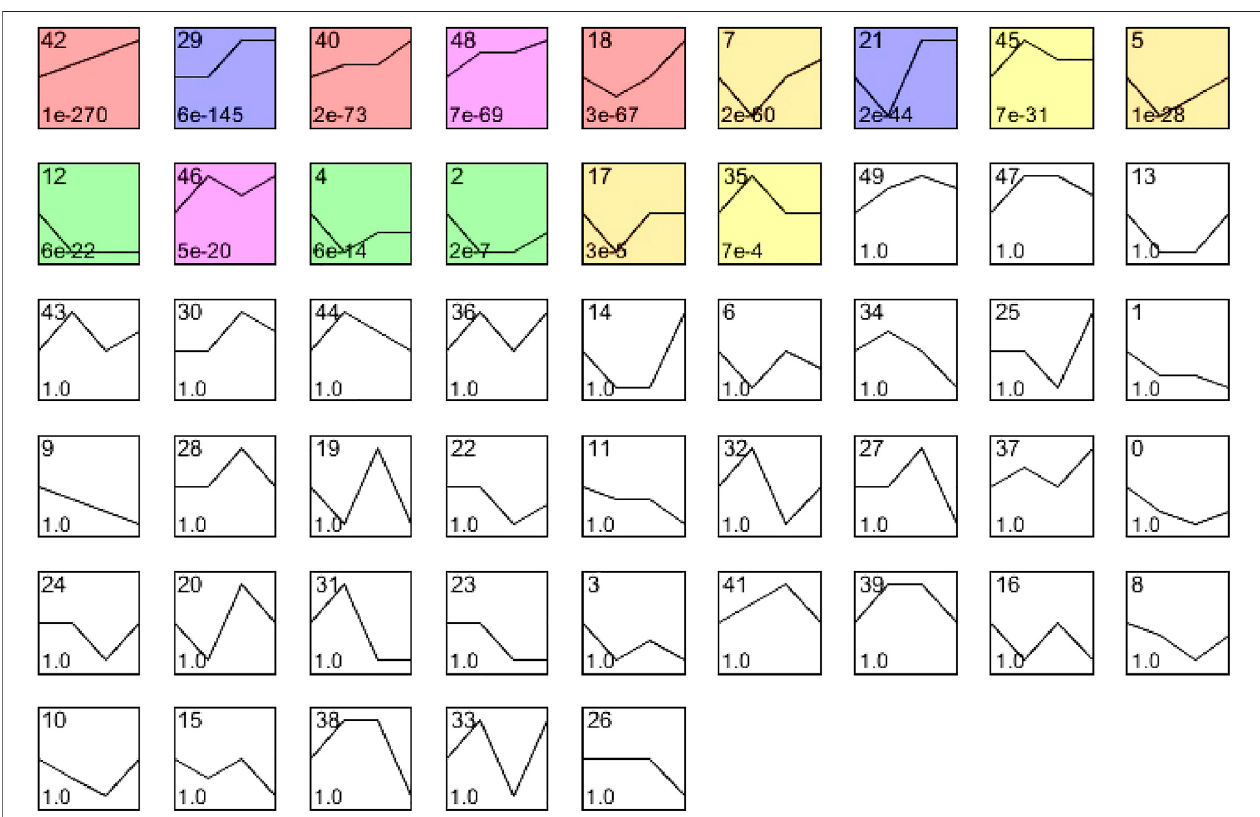
FIGURE3 | The cluster analysis ofDEGs insepticmyocardium.Mice weresubjected toCLP for 24, 48,and 72 h (n= 5per group). Basedon temporal expression pro fi le similarity, 5,607 DEGs were grouped into 50 gene expression pro fi les, of which 15 pro fi les (No. 42, 29, 40, 48, 18, 7, 21, 45, 5, 12, 46, 4, 2, 17, and 35) were signi fi cantly altered between septic heart and sham control (colored